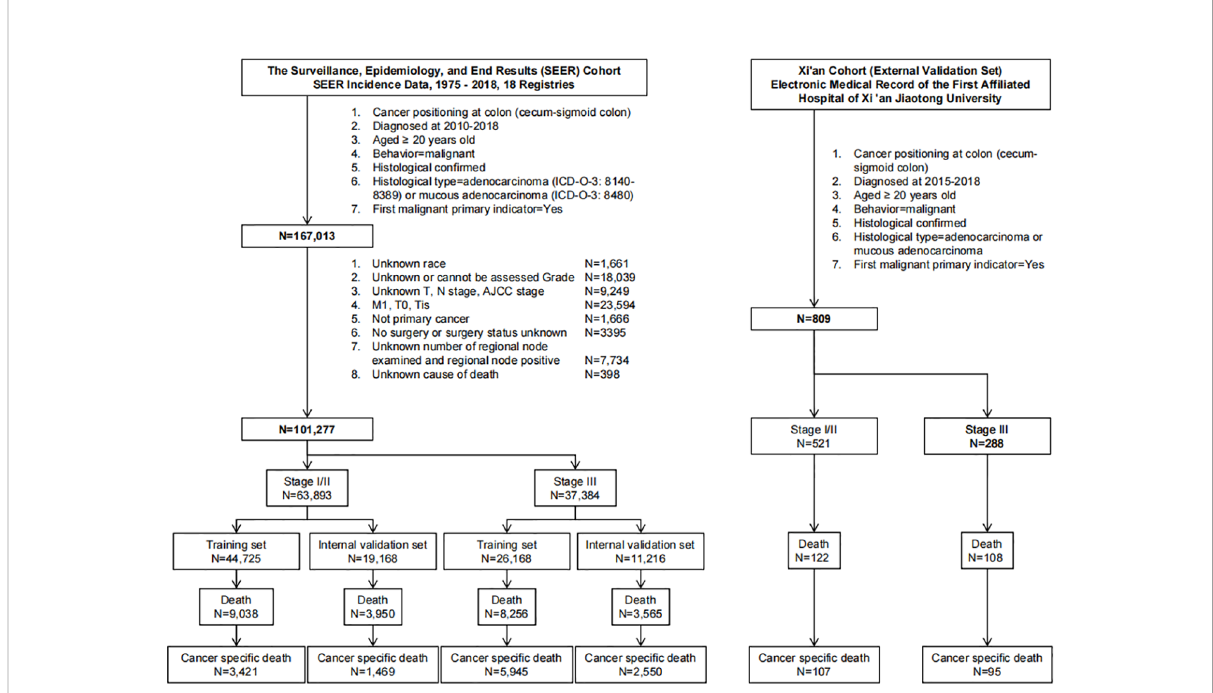
FIGURE 1 Flowchart for data retrieval and fi ltration of patients with colon cancer from the SEER database and